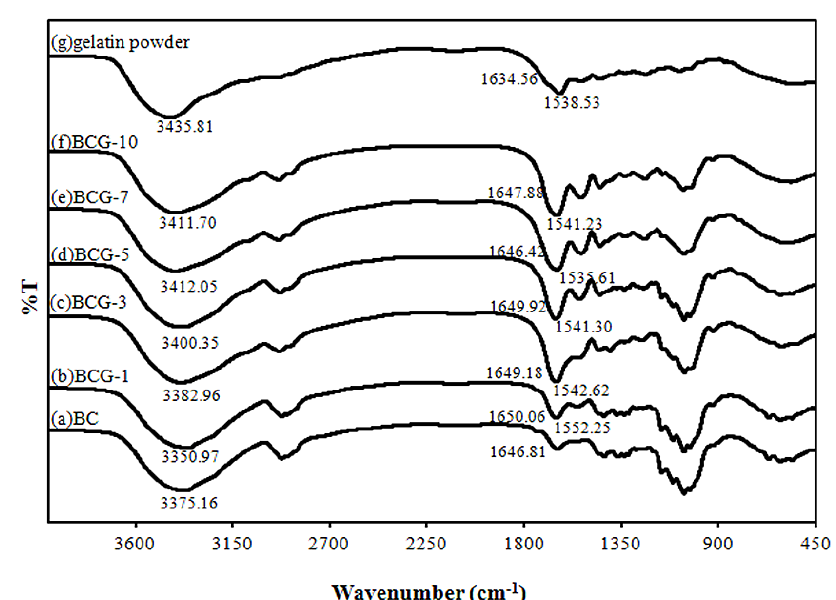
Figure 3. The Fourier transform infrared spectroscopy (FTIR) spectra of the BC, BCG and gelatin films: ( a ) BC; ( b ) BCG-1; ( c ) BCG-3; ( d ) BCG-5; ( e ) BCG-7; ( f ) BCG-10 and (g) gelatin